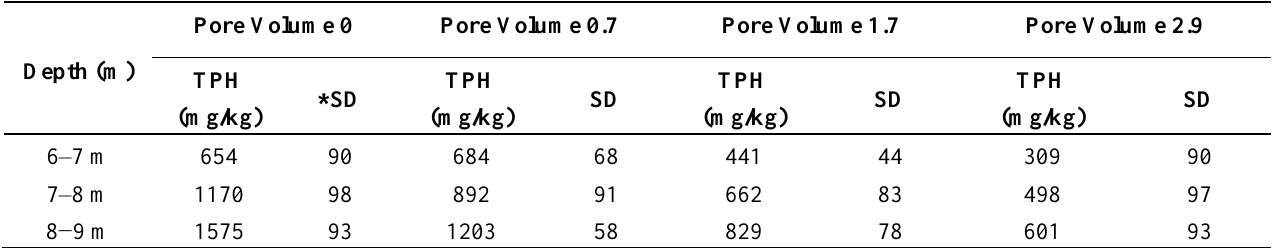
Table 3. TPH concentrations of soils relative to the pore volume for full-scale operation at a petroleum-polluted military